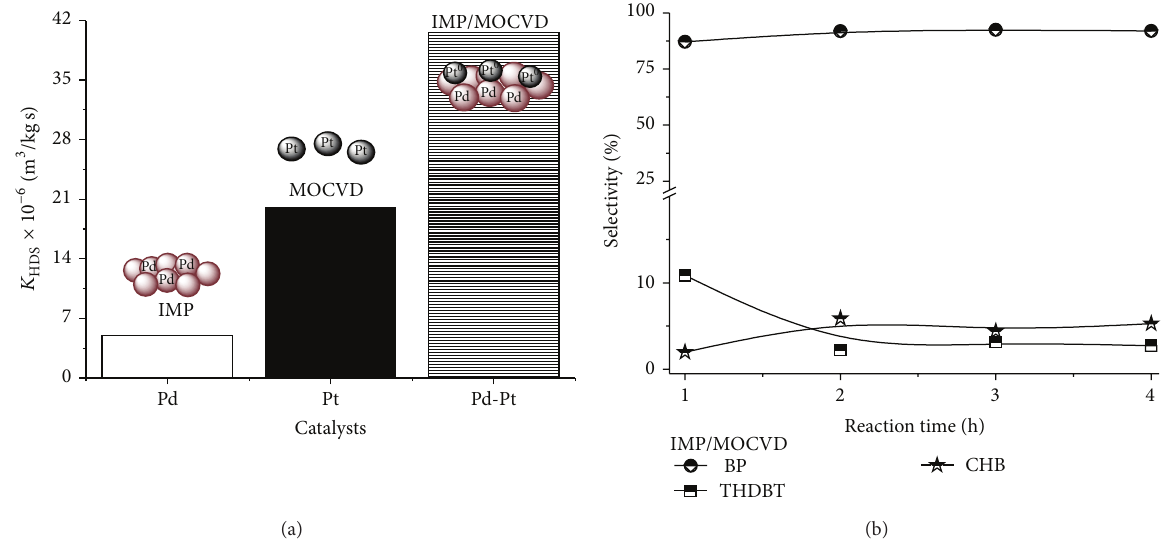
Figure 9: (a) Pseudo-first-order HDS intrinsic kinetic constants over Pd-IMP, Pt-MOCVD, and Pd-Pt-IMP/MOCVD catalysts evaluated in the HDS of DBT and (b) profiles of HDS selectivity over Pd-Pt-IMP/MOCVD catalysts ( 𝑃 = 5.59 MPa, 𝑇 = 350 ∘